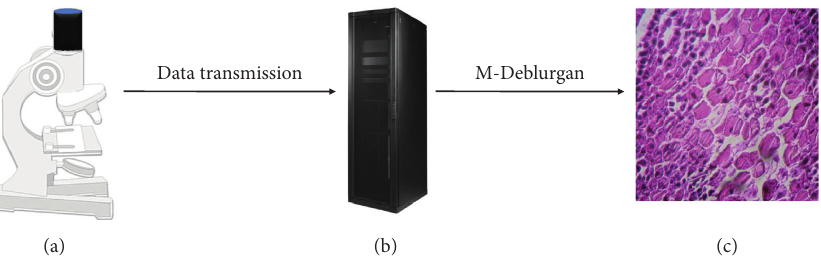
Figure 3: Experimental data acquisition and processing setup. (a) Optical microscope. (b) Computer. (c) Processed image.